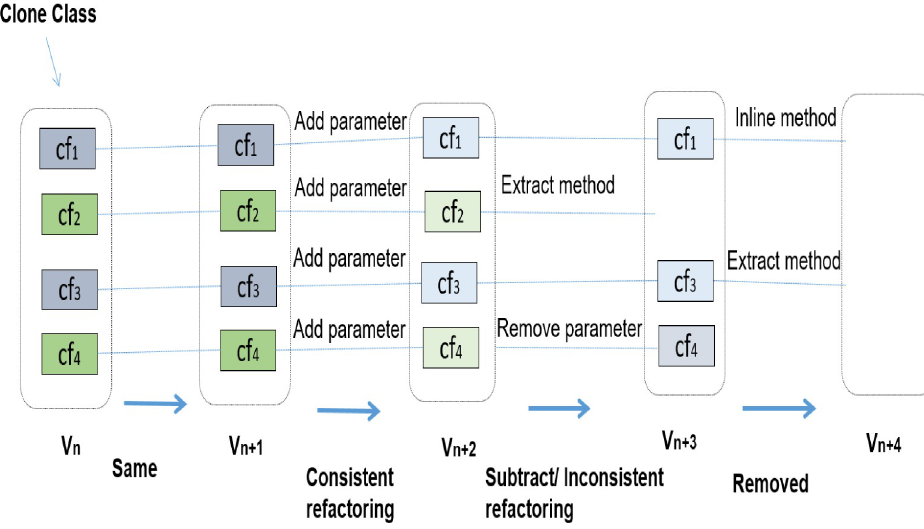
Fig 3. Different evolution patterns of clone refactoring between software